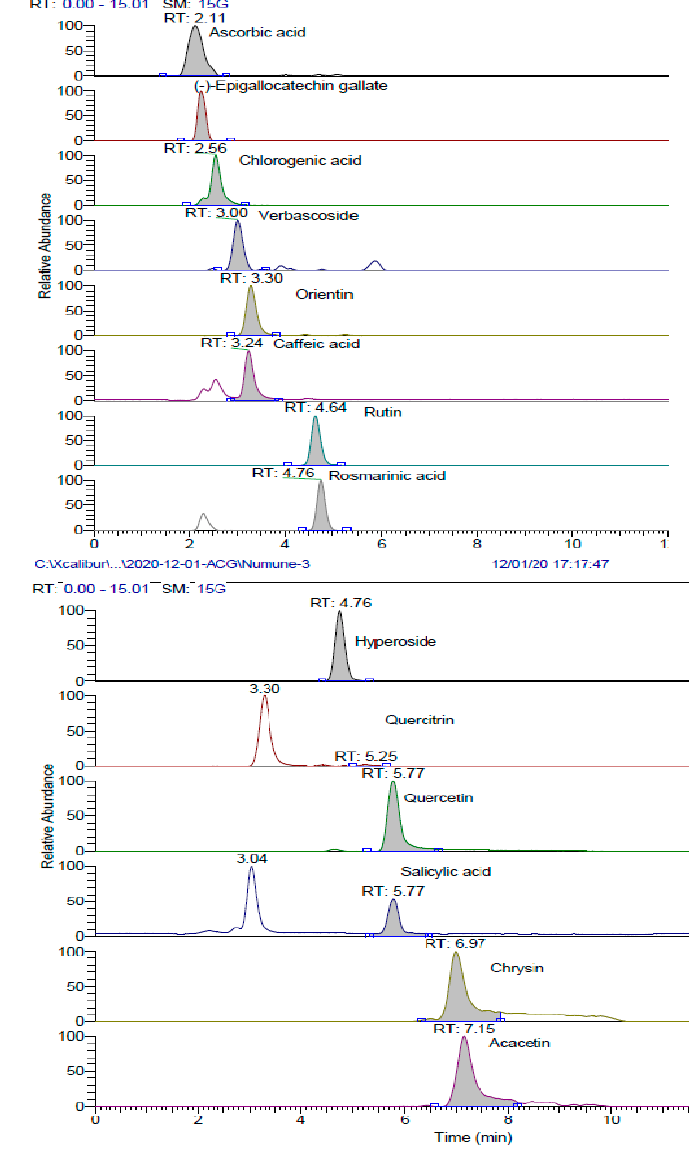
Figure 2. Liquid chromatography-high-resolution mass spectrometry (LC-HRMS) chromatogram of WEFS measurements (WEFS: lyophilized water extract of aerial parts of kınkor ( Ferulago stellata )). ( A ) Total ion chromatogram (TIC) in negative ionization mode and ( B ) HRMS.